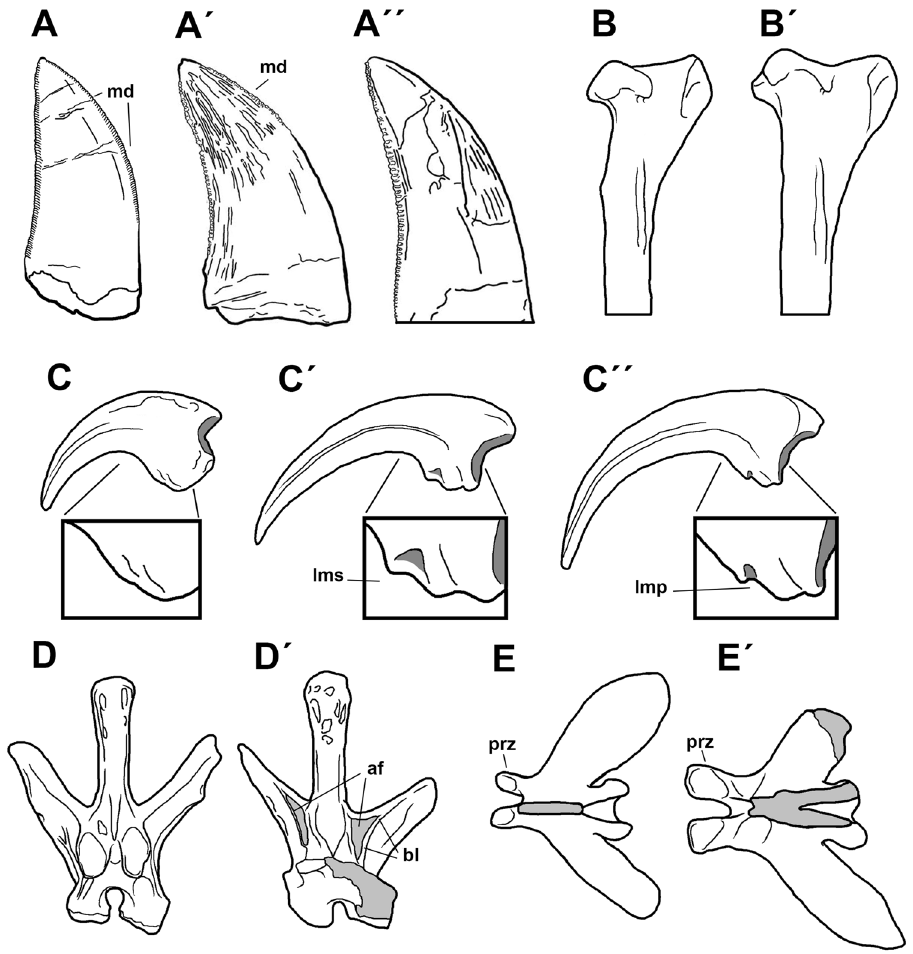
Figure 16. Comparative drawings showing the features that supports Clade “A” ( A – C ) and Clade “B” ( D – E ). A, maxillary tooth of Fukuiraptor ( A ), Australovenator ( A´ ) and Murusraptor ( A´´ ). B, proximal end of tibia of Australovenator ( B ) and Aerosteon ( B´ ). C, manual phalanges and close-ups of their flexor tubercles of Fukuiraptor ( C ), Australovenator ( C´ ) and Megaraptor ( C´´ ). D, dorsal vertebrae of Murusraptor ( D ) and Tratayenia ( D´ ). E, dorsal view of a mid-caudal vertebra of Megaraptor ( E ) and Maip ( E´ ). Abbreviations: af, accessory fossa; bl, bifurcated lamina; lmp, lateromedial platform; lms, lateromedial sulcus; md, mesial denticles; prz,